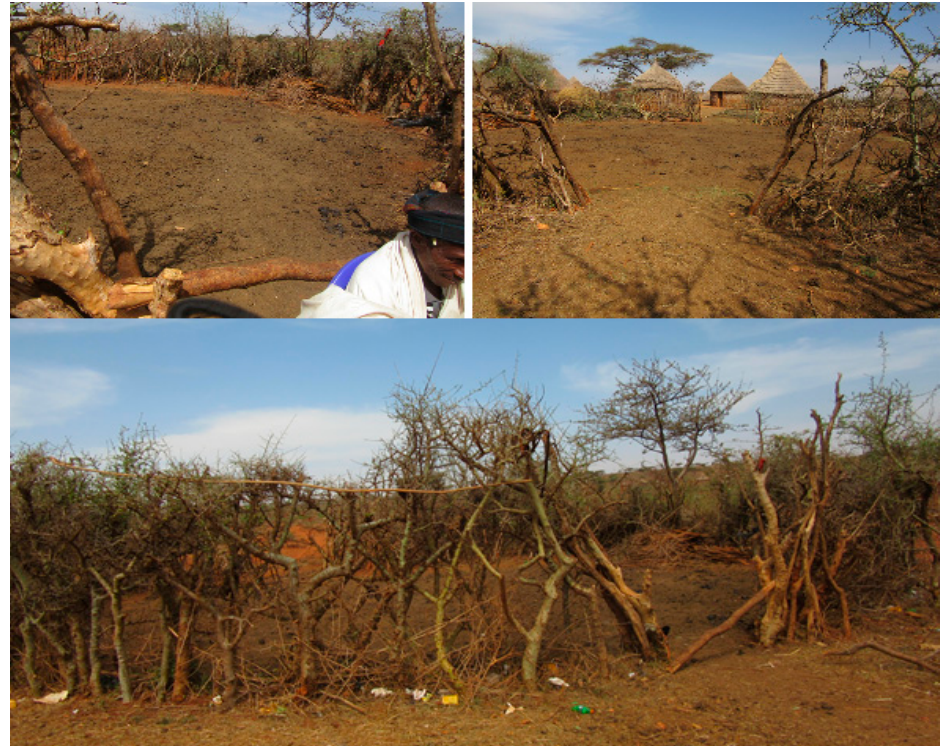
Figure 2. Large cattle kraal (locally called monna) in Borana, southern Ethiopia. Photograph by the first author.